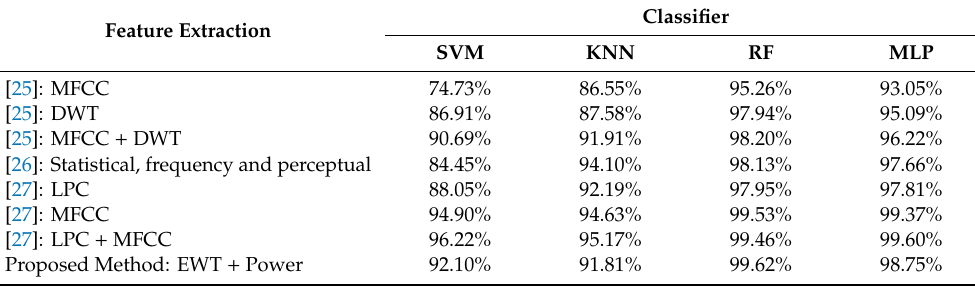
Table 15. Results of AUC between the methods [25–27] and the proposed.